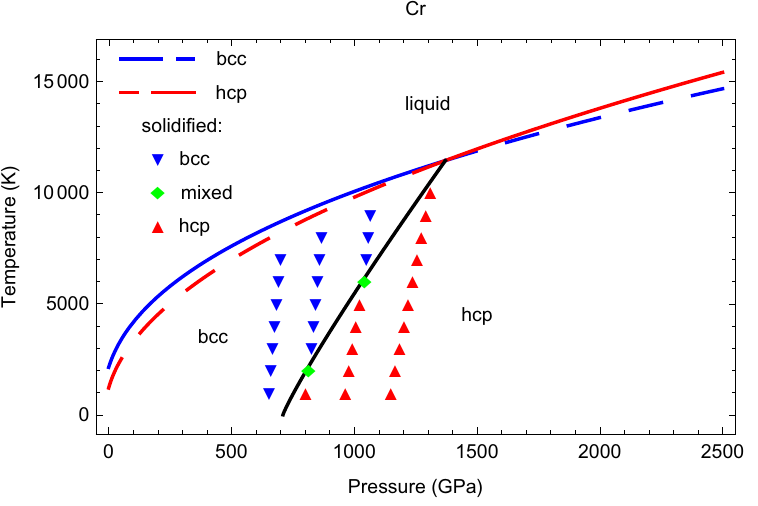
Figure 6. The theoretical phase diagram of Cr based on ab initio quantum molecular dynamics (QMD) simulations.